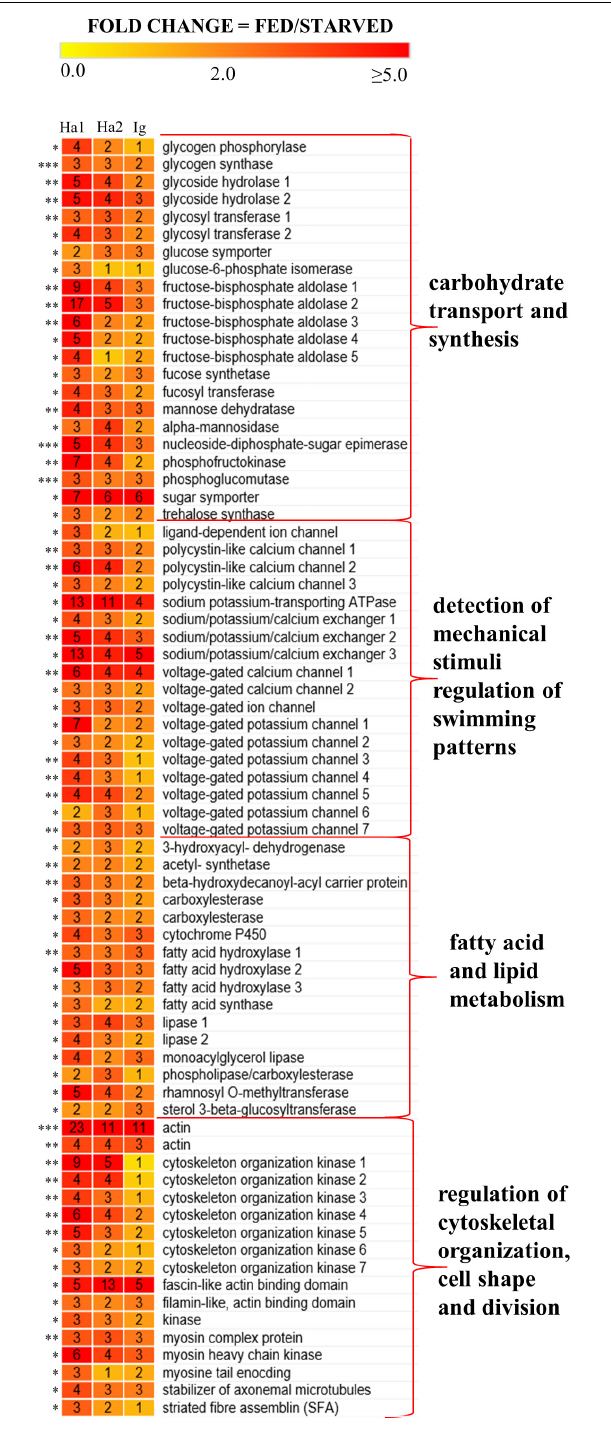
FIGURE 5 | A heat map representing 67 transcripts that were up-regulated in starving O. marina cells compared to O. marina cells fed on H. akashiwo 1 (Ha1), H. akashiwo 2 (Ha2), I. galbana (Ig). Numbers inside boxes indicate fold change for each prey. Asterisks next to each transcript indicate the number of prey types that were significantly differentially expressed. Names, contig IDs, and annotations of the transcripts can be found in Supplementary Files S1, S2